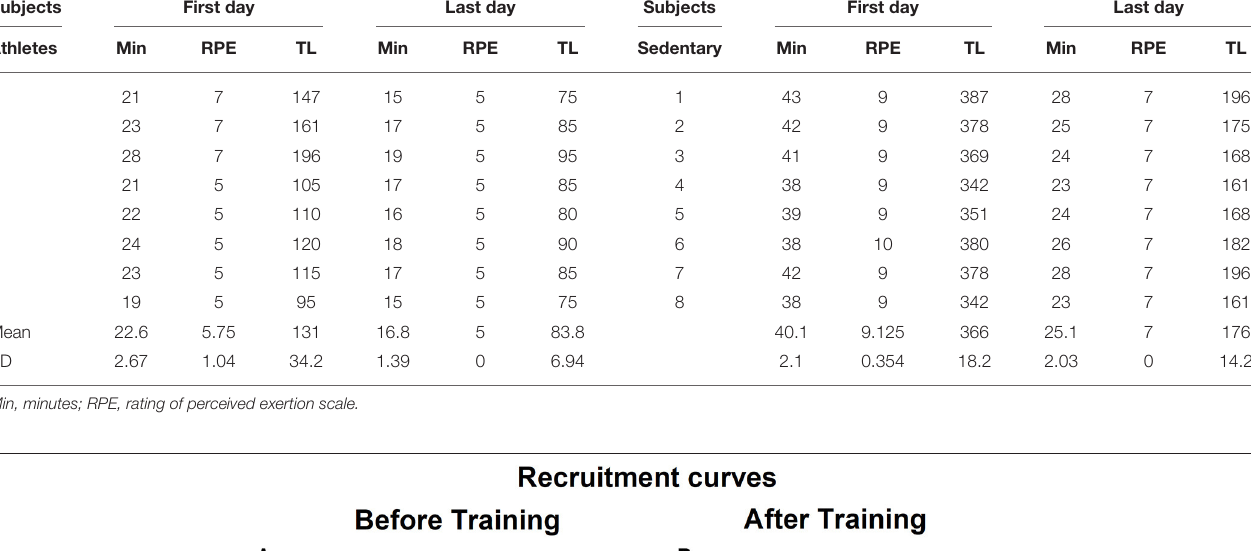
TABLE 4 | Training load (TL) in athletes and sedentary subjects. Subjects